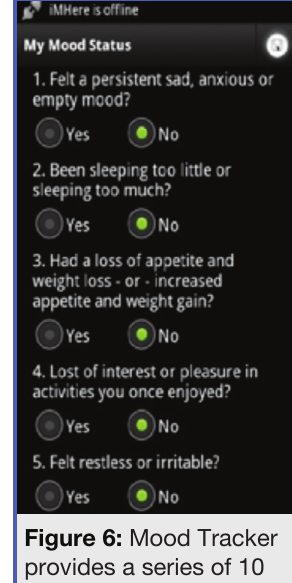
Figure 6: Mood Tracker provides a series of 10 yes/no questions to determine the user’s level of depression